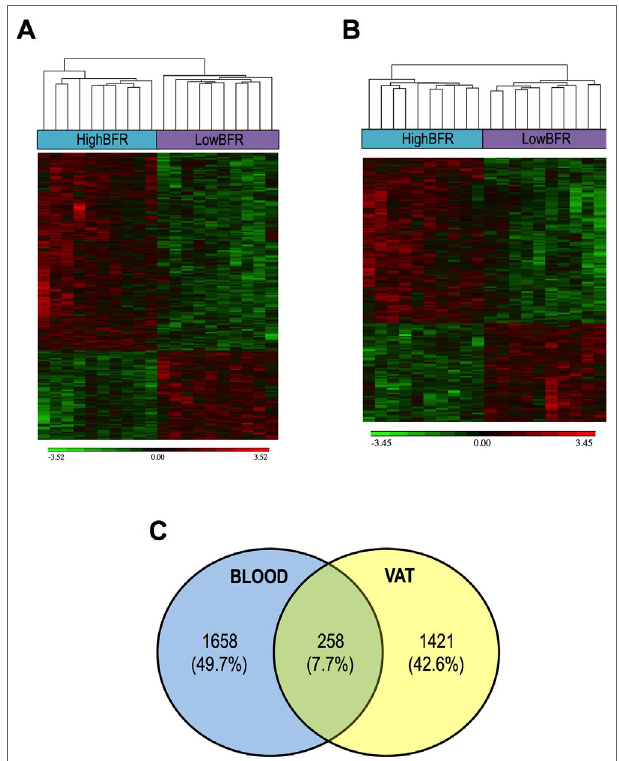
FIGURE 2 | Association between the gut microbiota composition and the DNA methylome in blood (A) and visceral adipose tissue (VAT) (B) . The analysis of methylation data yielded a set of genes that were significant differentially methylated among subjects with a predominance of either Bacteroidetes (HighBFR) or Firmicutes (LowBFR) in the gut microbial population. Green indicates decreased and red indicates increased methylation in the LowBFR group compared with the promoter methylation in the HighBFR group. (C) Venn diagram of genes differentially methylated in both whole blood and visceral adipose tissue.